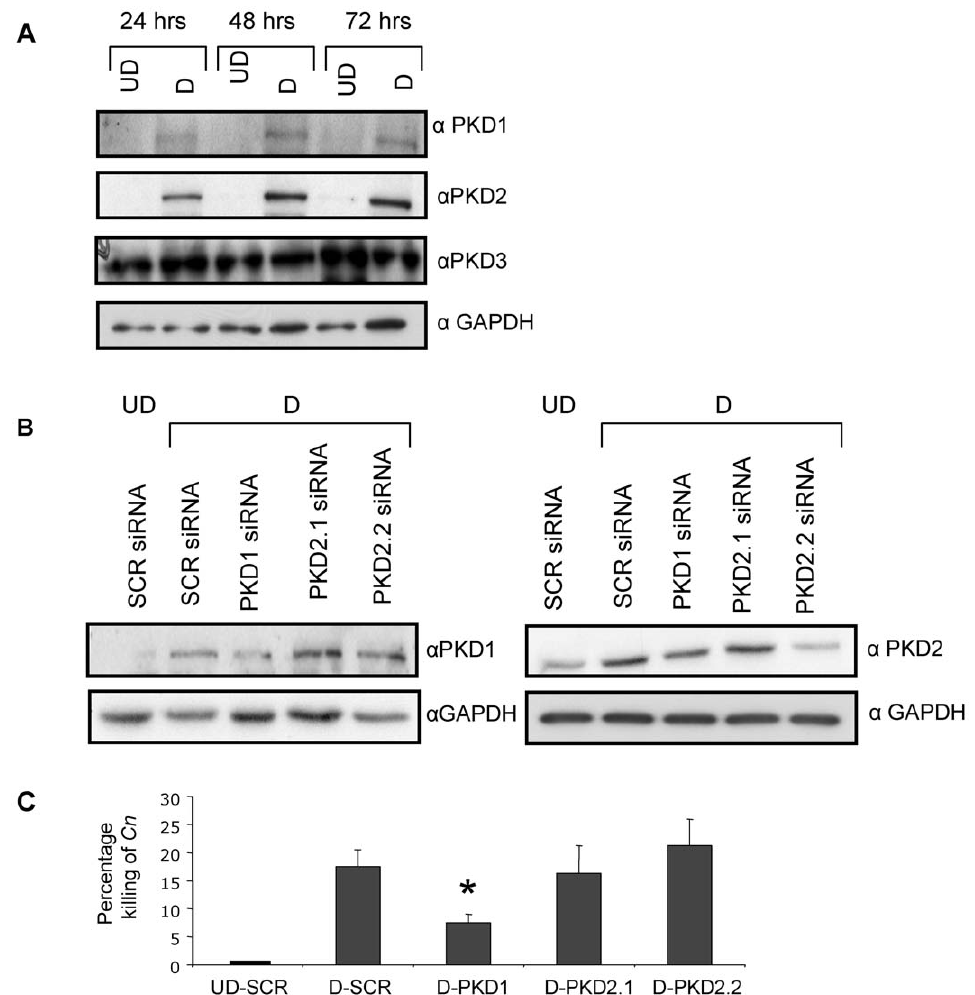
Figure 5. PKD isoforms during HL-60 cell differentiation. ( A ) HL-60 cells were plated at 1 6 10 5 cells/ml and differentiation was induced. Differentiated and undifferentiated cells were collected at 24, 48 and 72 hrs and cellular lysates analyzed by Western blot for PKD1, PKD2, PKD3 and GAPDH. Blots are representative of 3 experiments. ( B ) Effect of modulation of either PKD1 or PKD2 by siRNA on PKD1 and PKD2 protein levels and GAPDH as loading control. ( C ) Effect of PKDs siRNA on the killing activity of differentiated HL-60 cells against C. neoformans . Results are representative of at least 3 independent experiments. * P , 0.05, compared to D-SCR cells. UD, undifferentiated cells; D, differentiated cells; SCR: control scrambled